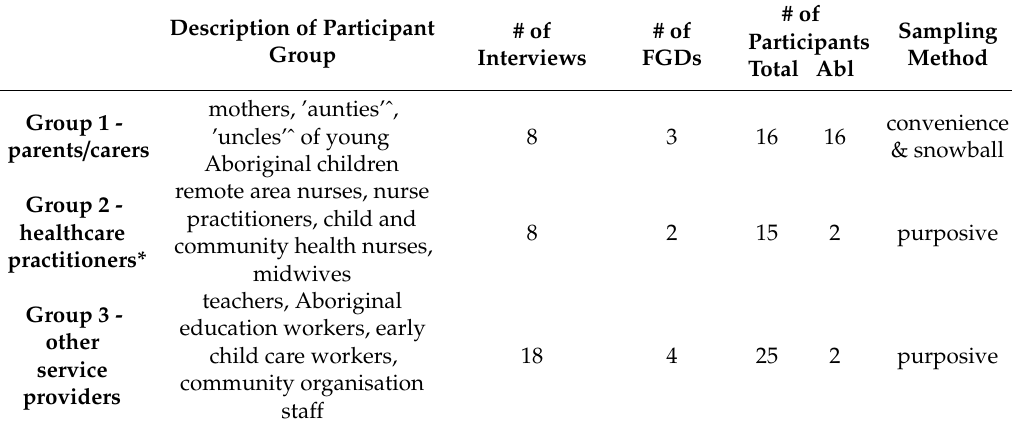
Table 2. Summary of data collection